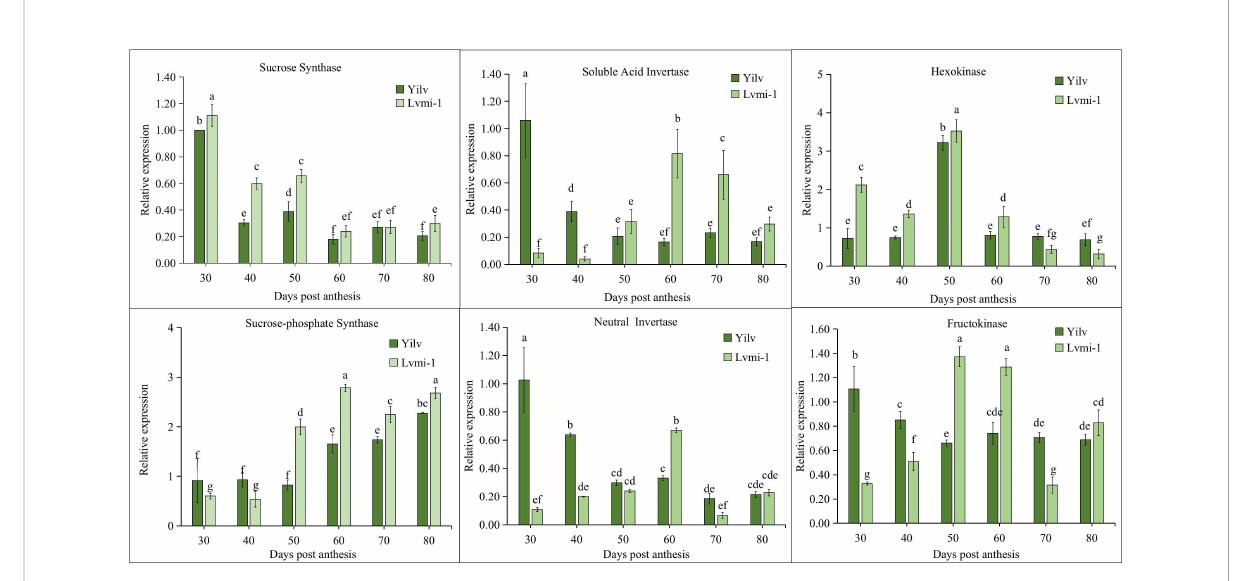
FIGURE 7 Expression pro fi ling of genes related to sugar and starch metabolism during fruit development in ‘ Yilv ’ and ‘ Lvmi-1 ’ . Relative expression was normalized against the value in the ‘ Yilv ’ fruit at 30 DPA. Error bars indicated the standard deviation of three biological replicates. Different letters indicated signi fi cant difference at the p ≤ 0.05 level.